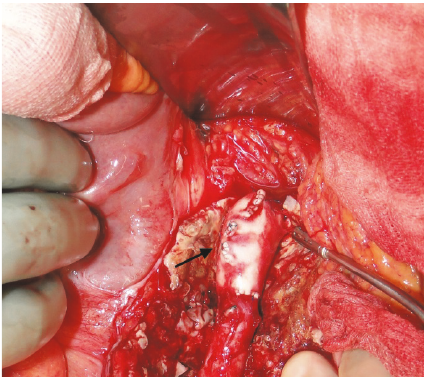
Figure 4: Intraoperative view showing the infrarenal aortic replace- ment with a homograft (black arrow)